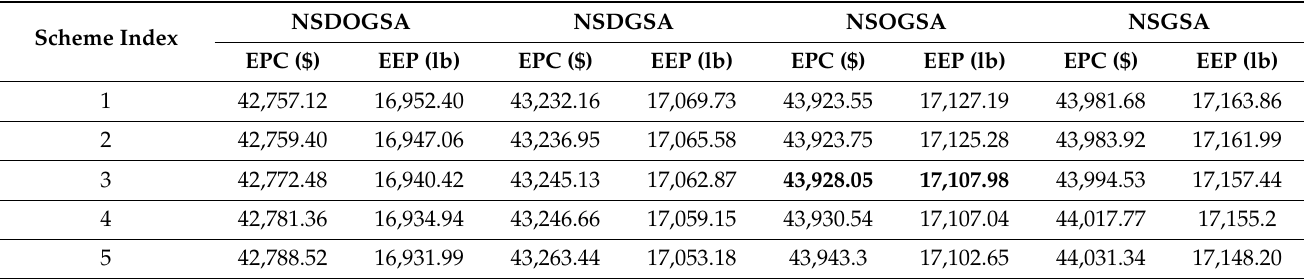
Table 4. Non-dominated solutions for MSHTS of Test System-I achieved using various